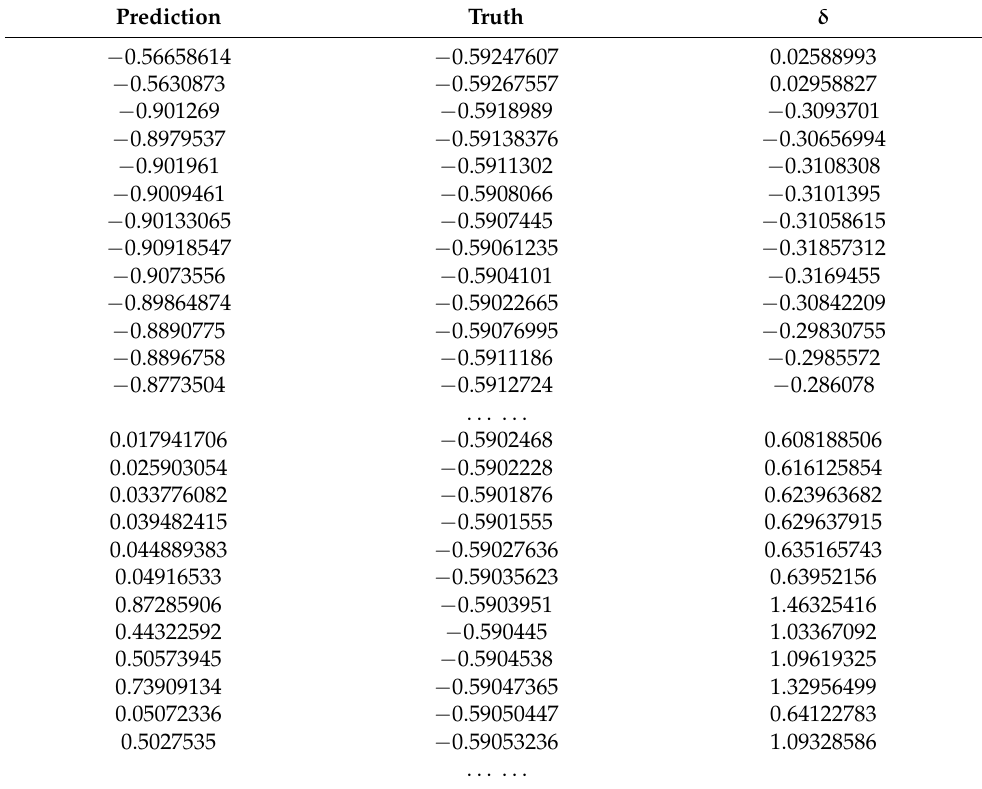
Table 2. The predicted values and actual values of D1.